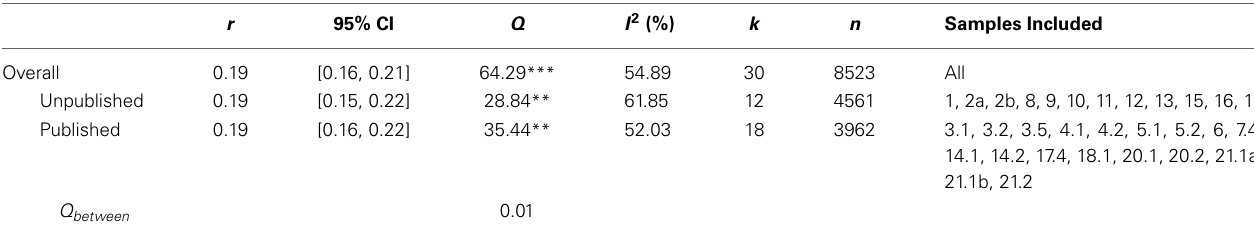
Table 5 | Fixed-effect between-level Q moderator analysis for publication